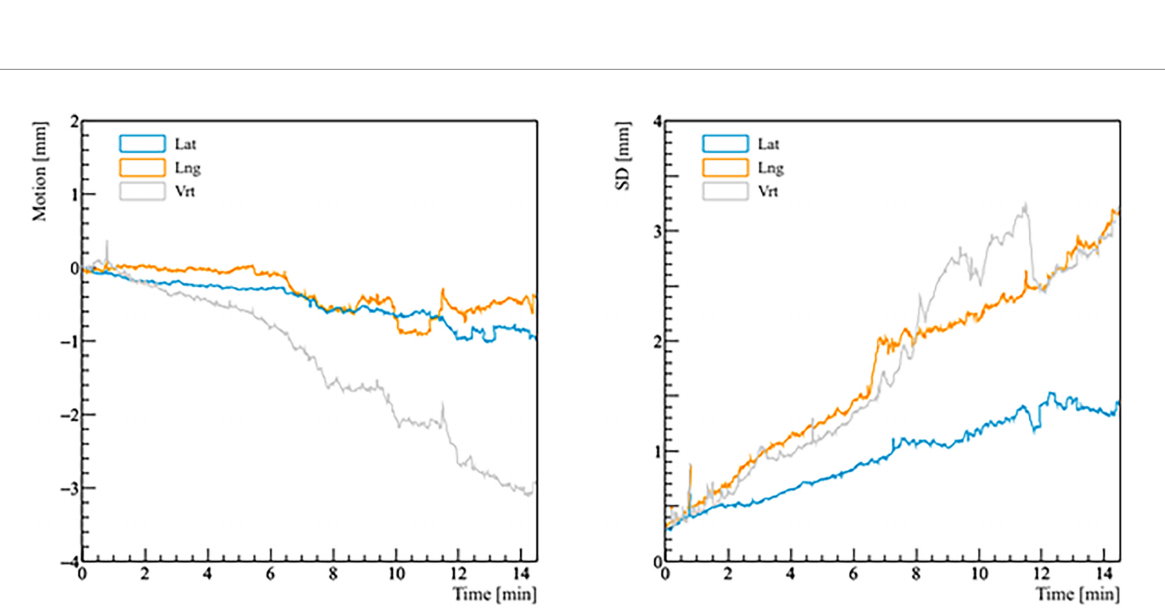
FIGURE 3 | Real prostate motion with no interruptions and patient position corrections as a function of time (t = 0 at the beginning of the initial CBCT). The left panel shows the mean variations from the initial position of the prostate, the right panel shows the standard deviation (SD) of the mean